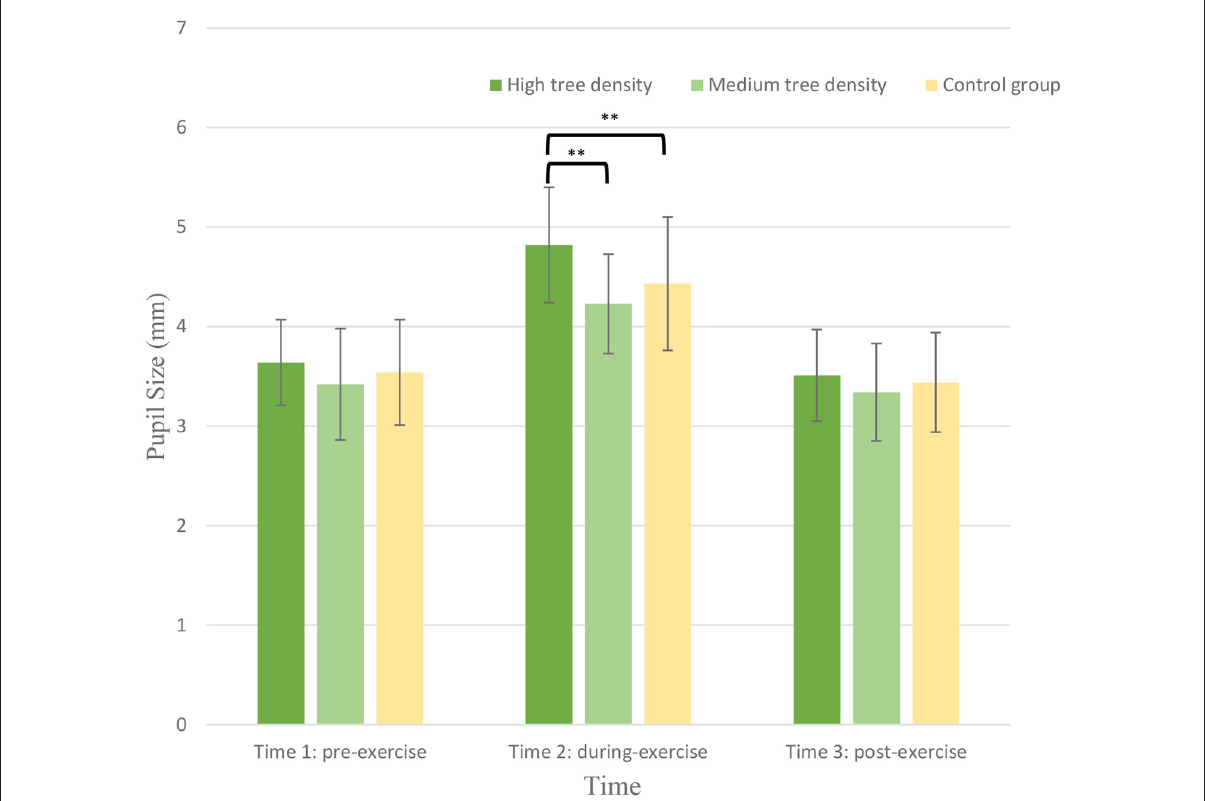
FIGURE4 Pupil size for the high tree density sportscape (HTDS) and the medium tree density sportscape (MTDS) groups at 3 different time points. (** p <